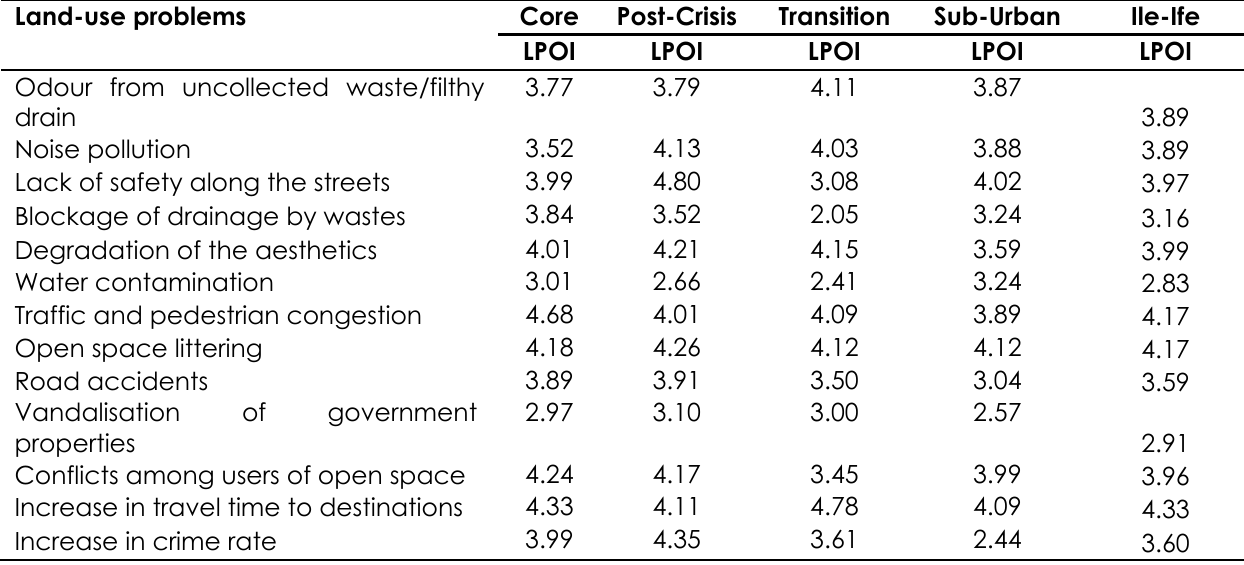
Table 4. Land-use challenges associated with marginal